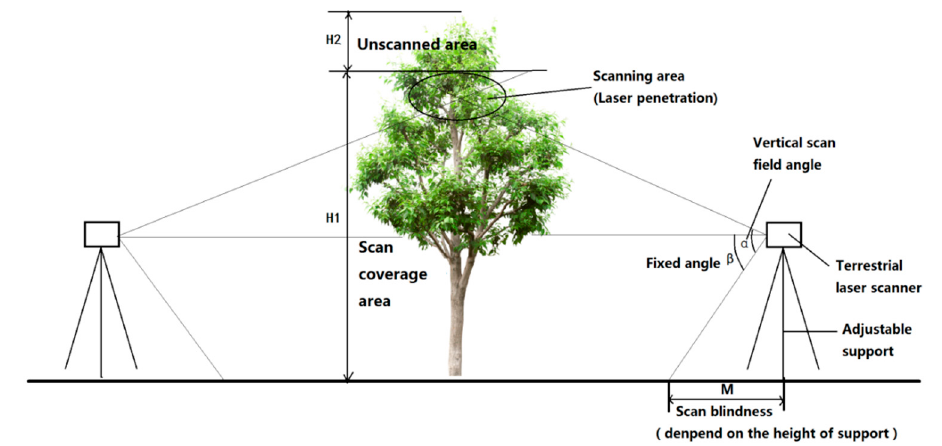
Figure 1. Missing information in the upper canopy of the TLS scanning observations because of the vertical scanning angle.